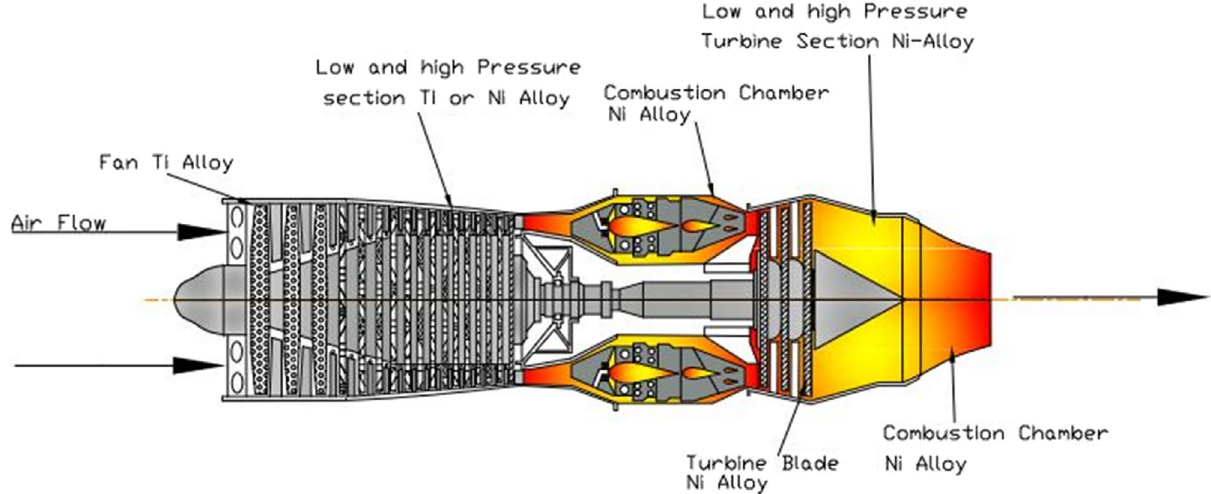
Figure 2. Utilises for nickel-based superalloys, which typically account for around 50% of a jet engine’s